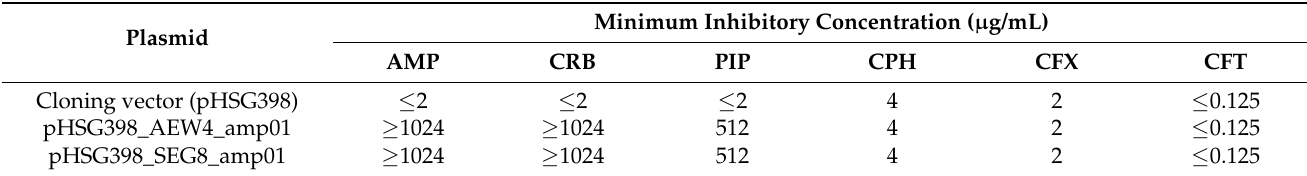
Table 4. Antibiotic susceptibility of E. coli harboring vector pHSG398 without or with insert.